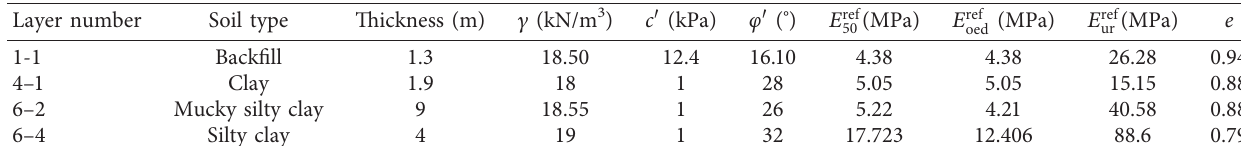
Figure 2: (a) Plan layout of the Haiheyuan project. (b) Profile and plan views of excavations retained by VIIP named M-1. (c) Profile and plan views of excavations retained by VP named M-2. Table 1: Soil parameters of Haiheyuan project.